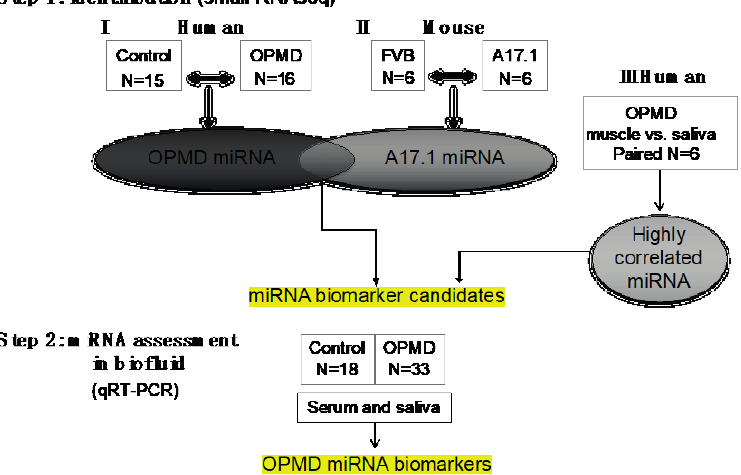
Figure 1. Workflow of our study. In step 1, the oculopharyngeal muscular dystrophy (OPMD)-miRNA candidates were identified in three RNAseq studies. ( I ) human control and OPMD, vastus lateralis (VL), ( II ) mouse OPMD model A17.1 and Friend Virus B laboratory mouse (FVB) control, tibialis anterior (TA). From both studies, di ff erentially expressed (DE) miRNAs were identified. ( III ) A small RNAseq in muscle and saliva from OPMD patients was carried out in order to identify the highly correlated miRNAs between muscle and saliva. miRNA candidates were selected from the three studies. In step 2, assessment of expression was carried out using qRT-PCR in both serum and saliva from control and